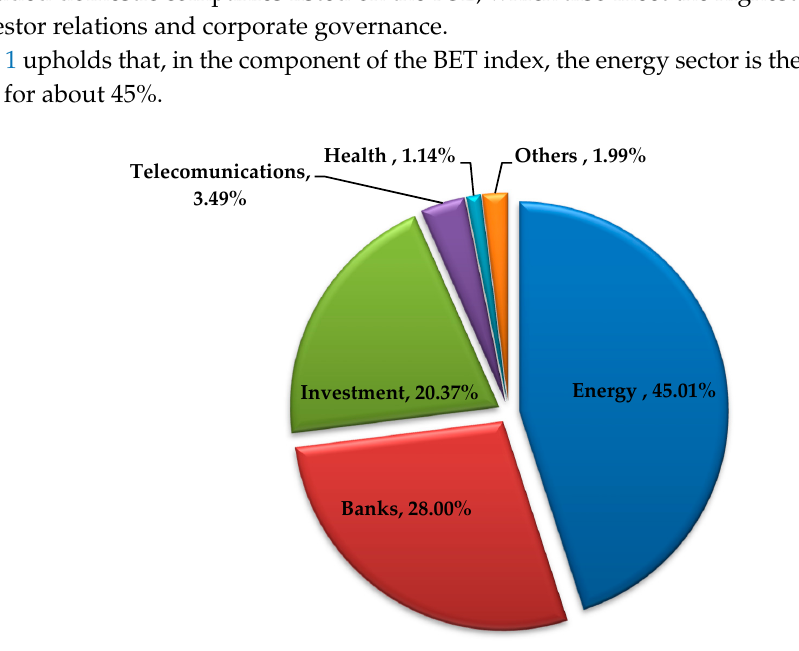
Figure 1. BET index sector weights (as of February 2019). Source: Authors’ work based on the Bucharest Stock Exchange data.